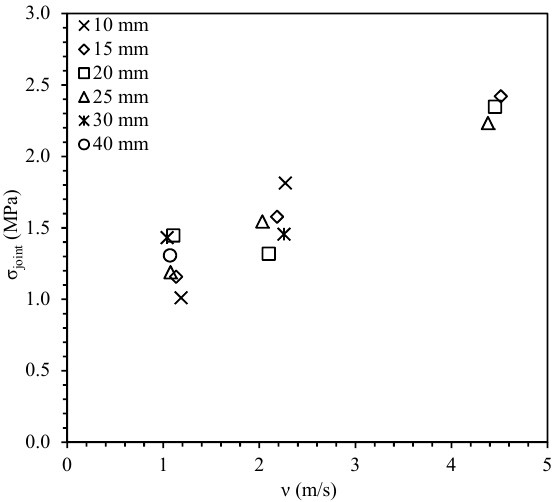
Fig. 6 Joint strength against displacement rate at a 30° pulling